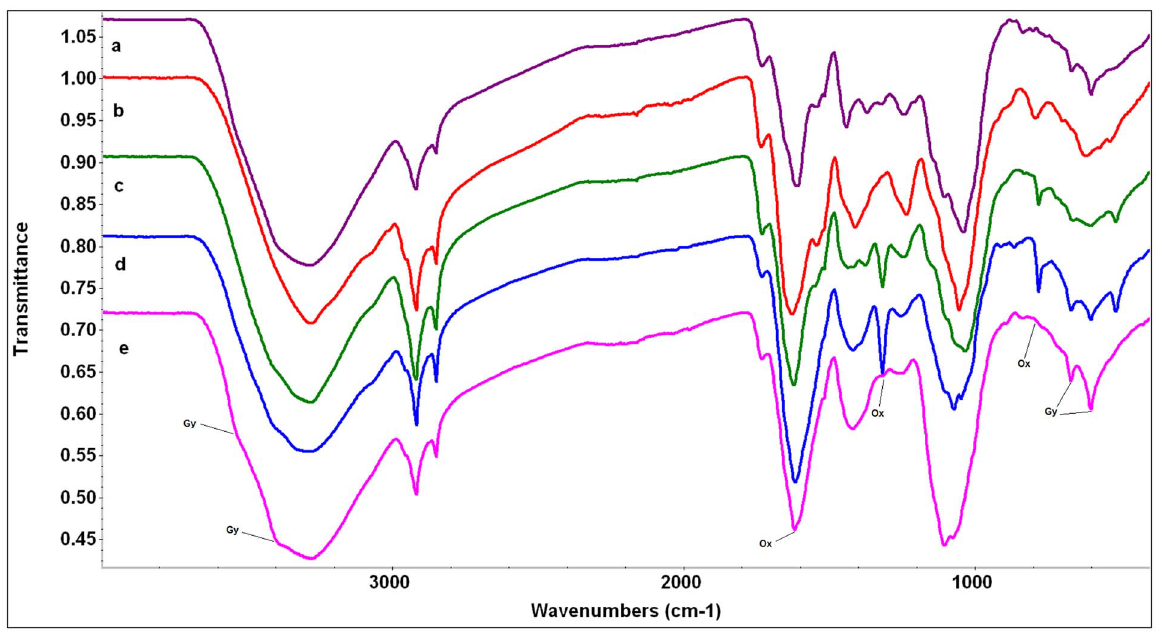
Figure 3. FTIR spectra of wide gypsophiles. The scale of the Y axis is offset for illustration purposes. a) Helianthemum squamatum (purple), b) Lepidium subulatum (red), c) Herniaria fructicosa (green), d) Gypsophyla struthium subsp. hispanica (blue), e) Ononis tridentata (pink). Abbreviations of compound peaks: Gy: Gypsum, Ox: Oxalate.